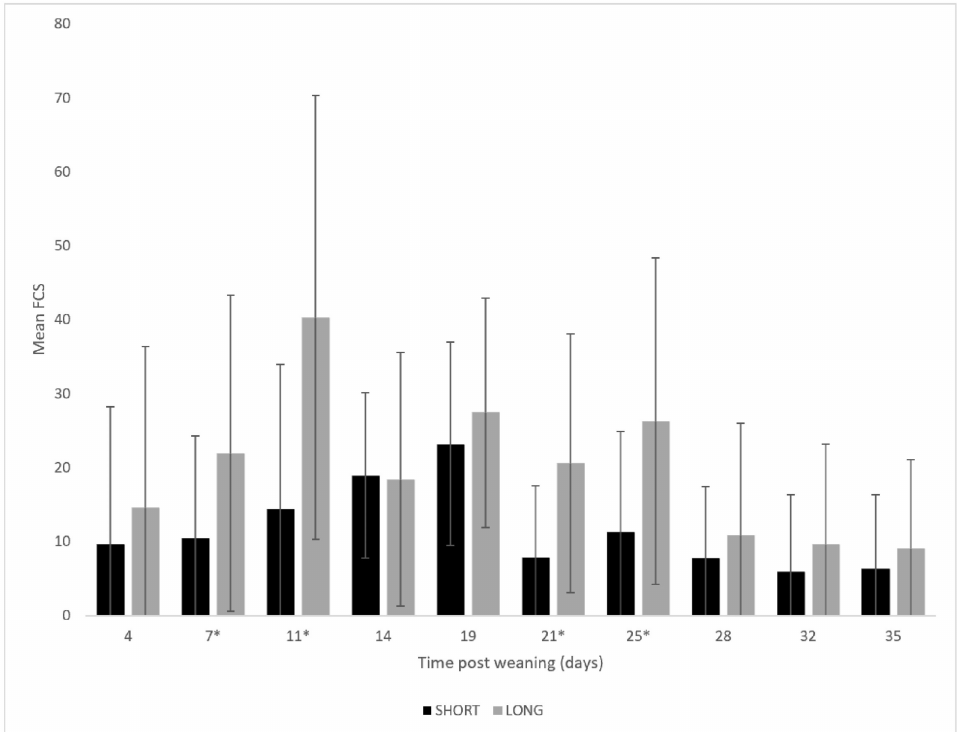
Figure 3. Faecal consistency scores (FCS) of piglets in the SHORT (black, 8 h light 16 h dark) and LONG groups (grey, 16 h light and 8 h dark). Scores (range: 0 = normal faeces) to 100 = severe watery diarrhoea) were measured twice weekly for each pen during the whole nursery period. Mean values are given for all the study pens (24 pens of 6 piglets for short and long groups). The standard deviation is given by the whiskers. ( p treatment × time < 0.001, p time < 0.001, p treatment < 0.001; * indicates significant differences per time point).